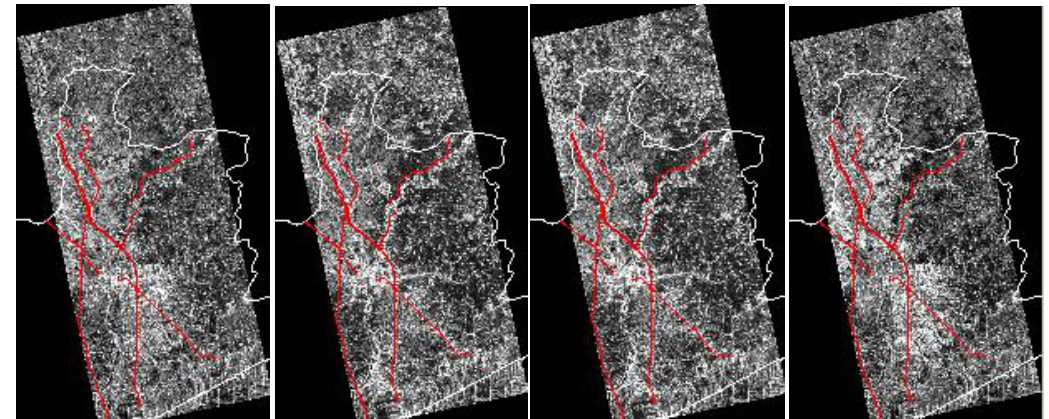
Figure 4. ALOS/PALSAR image (Scene ID: ALPSRP067770280-P1.5GUA), with back scattering in the HH, HV,VH and VV polarization, overlaid with highways (red) and the Ayutthaya provincial boundary